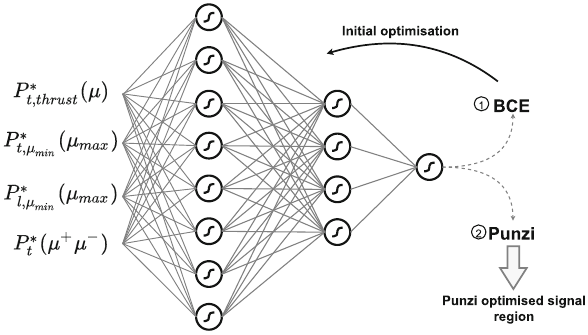
Fig. 1 An outline of the network architecture. The first training with the BCE loss function was used to set the weights and biases of the net for the second training with the custom loss function based on the Punzi FOM